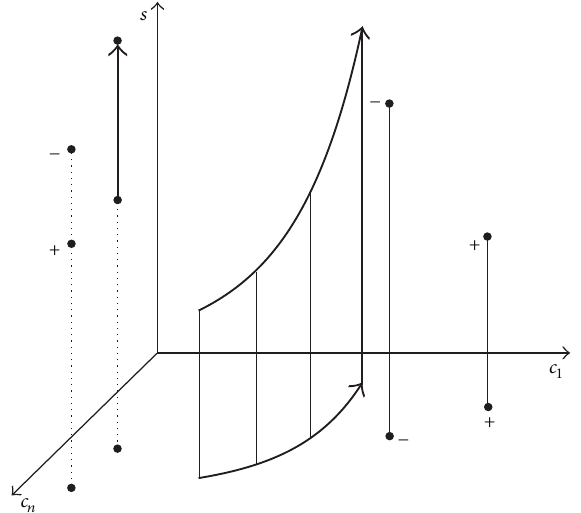
Figure 5: Projection of the space of the large system into that of auxiliary system and the lifting procedure using the solution of auxiliary